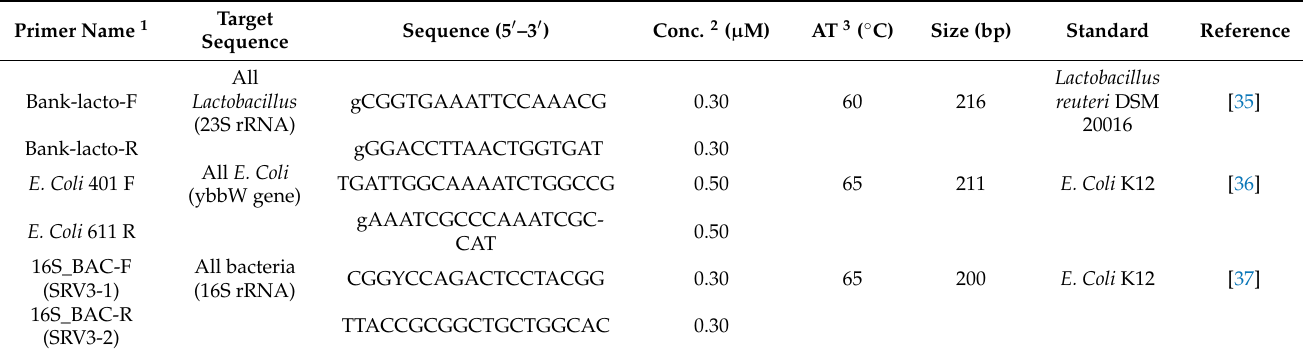
Table 2. Primers and quantitative PCR conditions used for real-time